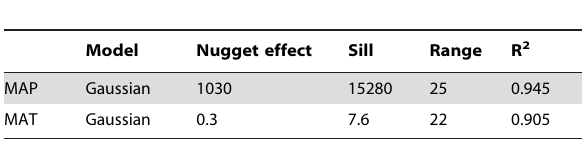
Table 1. Semi-variogram test of spatial autocorrelation of mean annual temperature (MAT) and mean annual precipitation (MAP) among sampling sites across a 2500-km long transect in northern